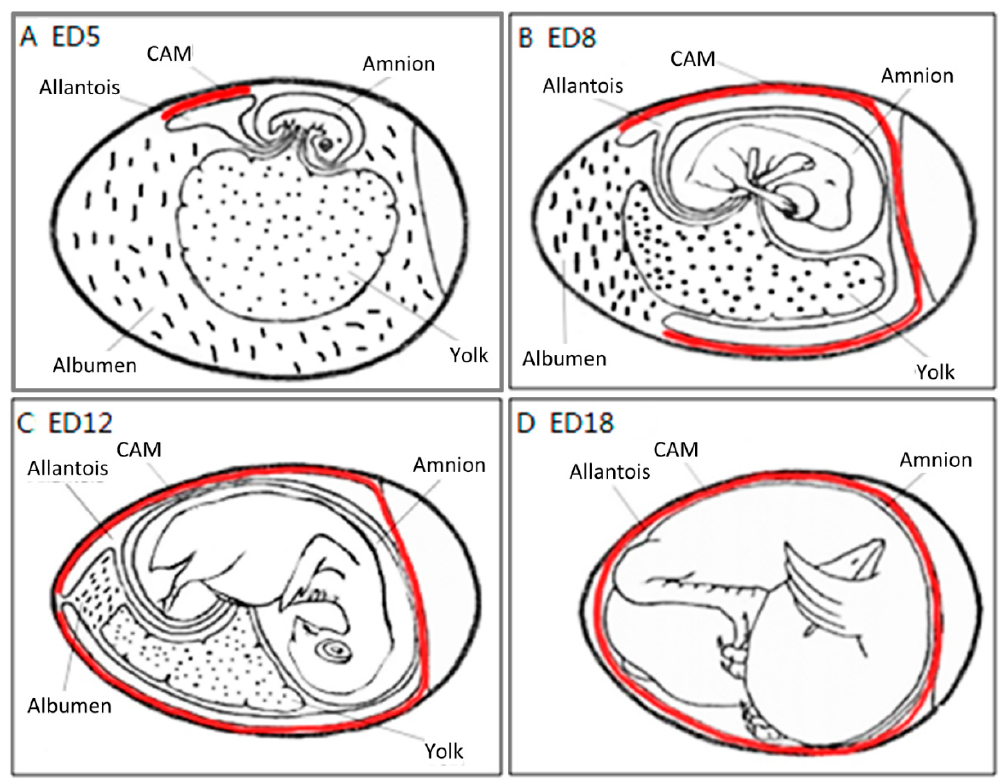
Figure 4. The development of the chorioallantoic membrane (CAM) (red lines) at different stages: ( A ) ED 5 initial coverage, ( B ) ED 8 half coverage, ( C ) ED 12 and ( D ) ED 18 full coverage of the chick embryo.